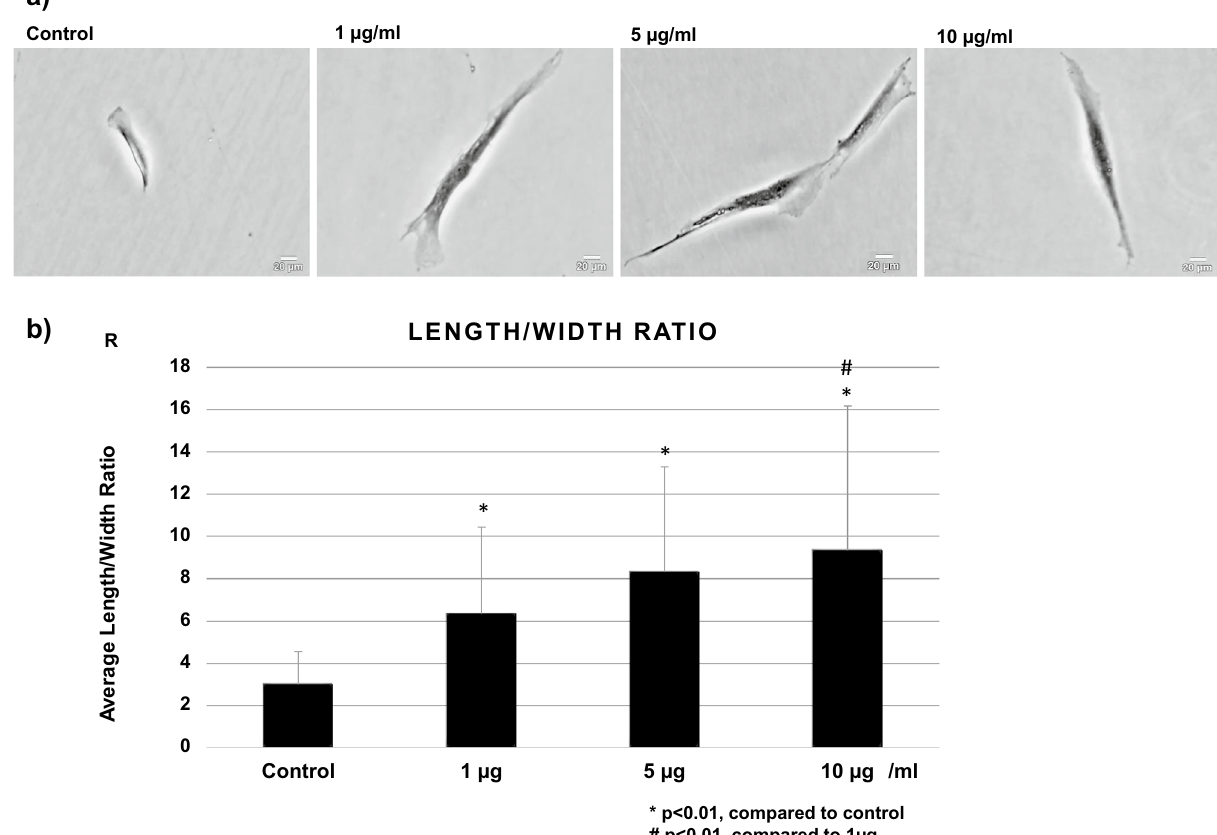
Figure 6. ( a ) Cell morphology, and ( b ) average length per width ratio in cells from hypertrophied LF post treatment with different BGN